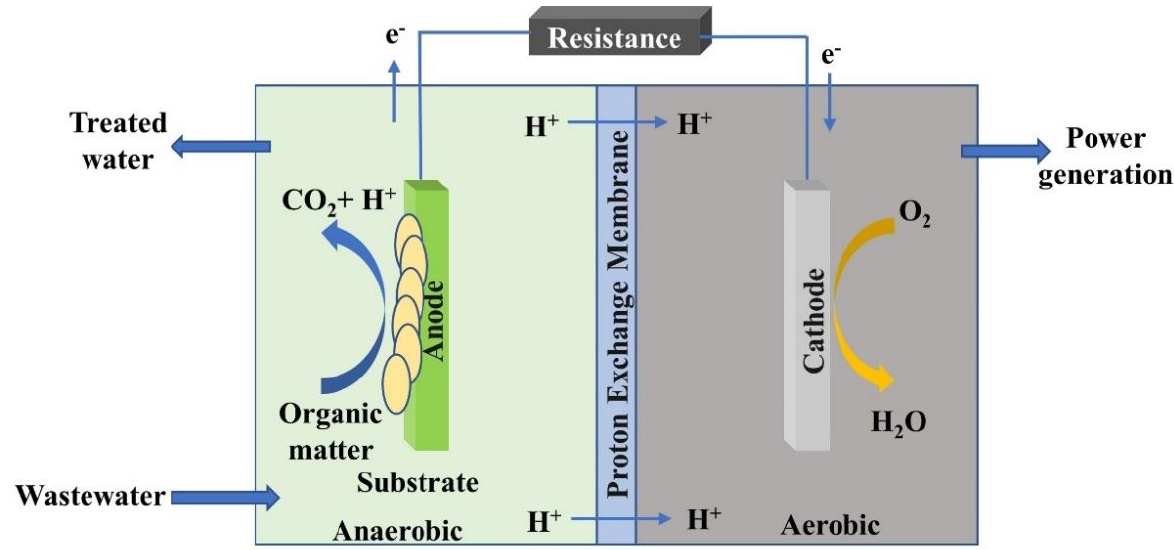
Figure 1. A schematic diagram of a typical dual-chamber microbial fuel cell.